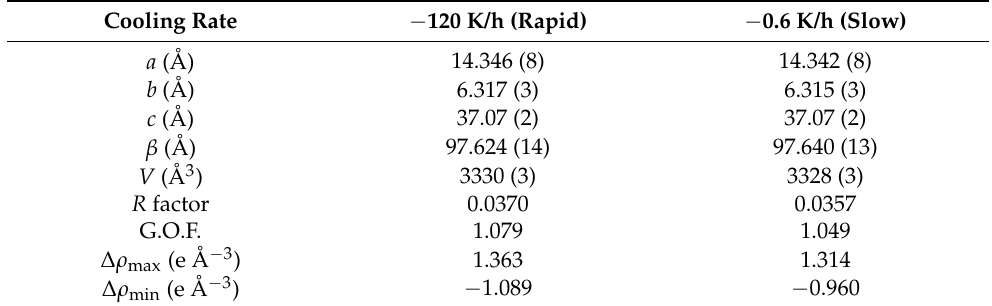
Table 1. Crystal data for β′ -EtMe 3 Sb[Pd(dmit) 2 ] 2 at 5 K obtained using two different cooling rates.